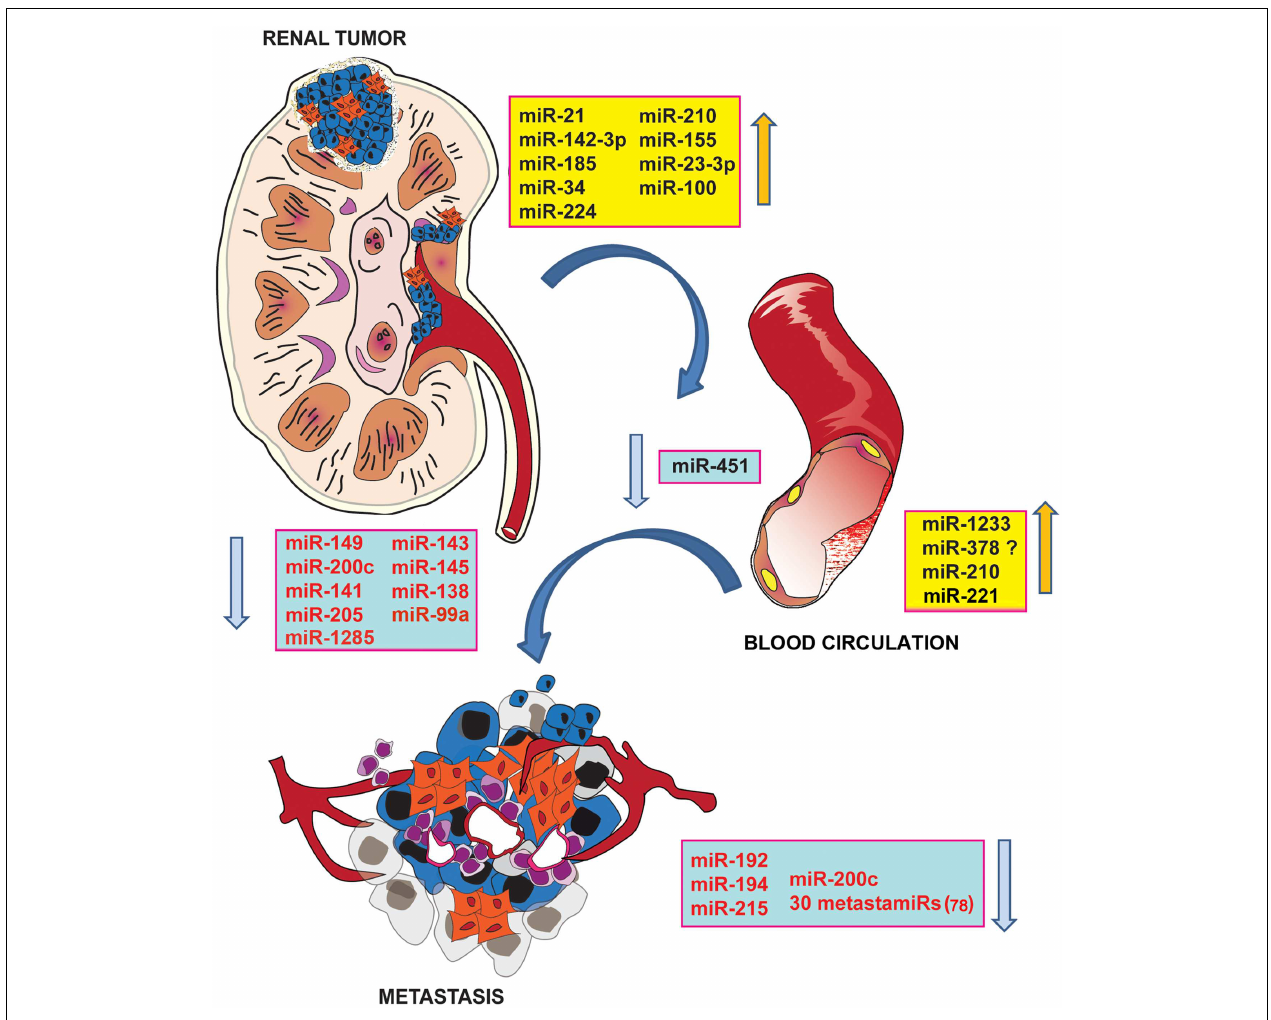
suppressor genes and anti-tumor miRNAs (in yellow), which target onco-proteins. miRNAs have been also correlated to the metastasization process. miRNA signature in metastatic RCC samples compared with primary RCC showed a significant reduction of some miRNAs (in yellow), targeting molecules involved in the EMT transition and invasion. miRNAs have been detected in serum of RCC patients, supporting their suitability as